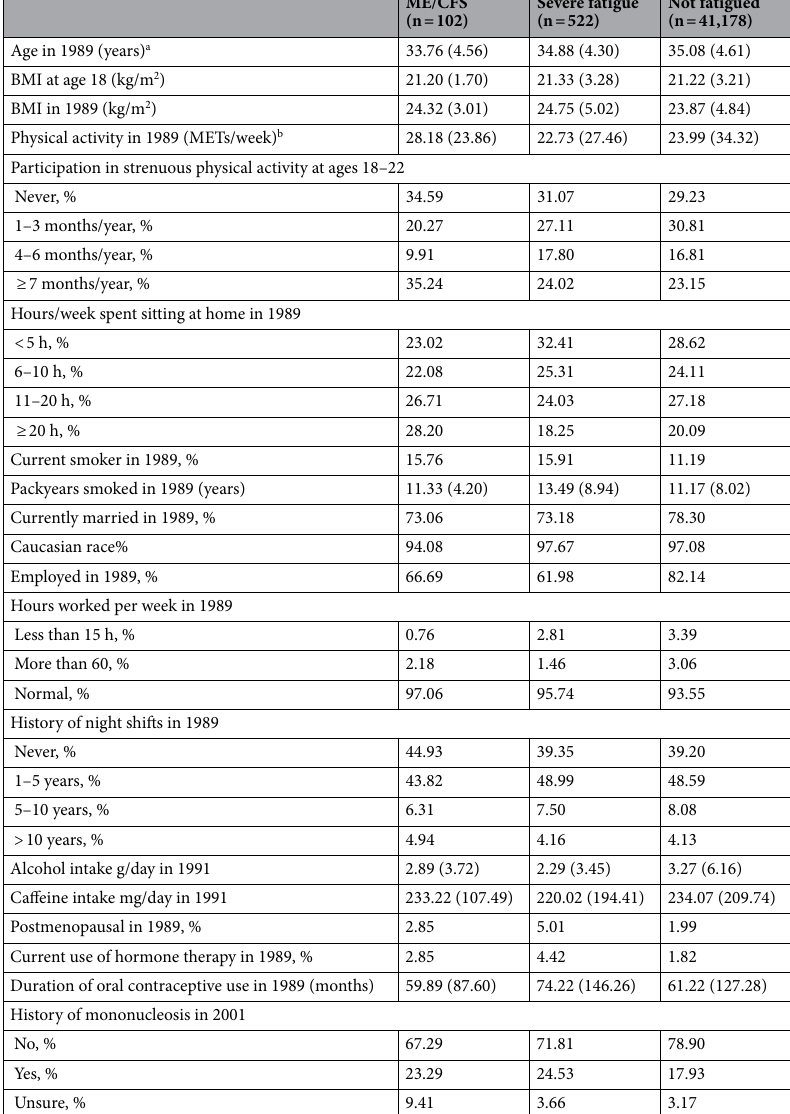
Table 1. Characteristics of NHS II participants who completed the fatigue questionnaire. Values are means (SD) or medians (Q25, Q75) for continuous variables; percentages or ns or both for categorical variables and are standardized to the age distribution of the study population. Values of polytomous variables may not sum to 100% due to rounding. BMI, body mass index. a Value is not age adjusted. b Metabolic equivalents (METs) from recreational and leisure-time